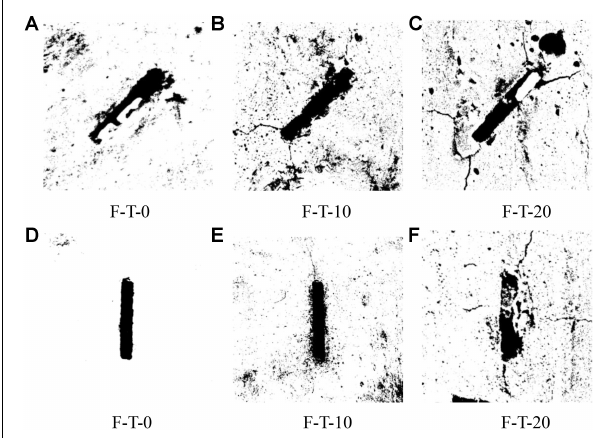
FIGURE 3 | Binarization image of localized damage under different F-T